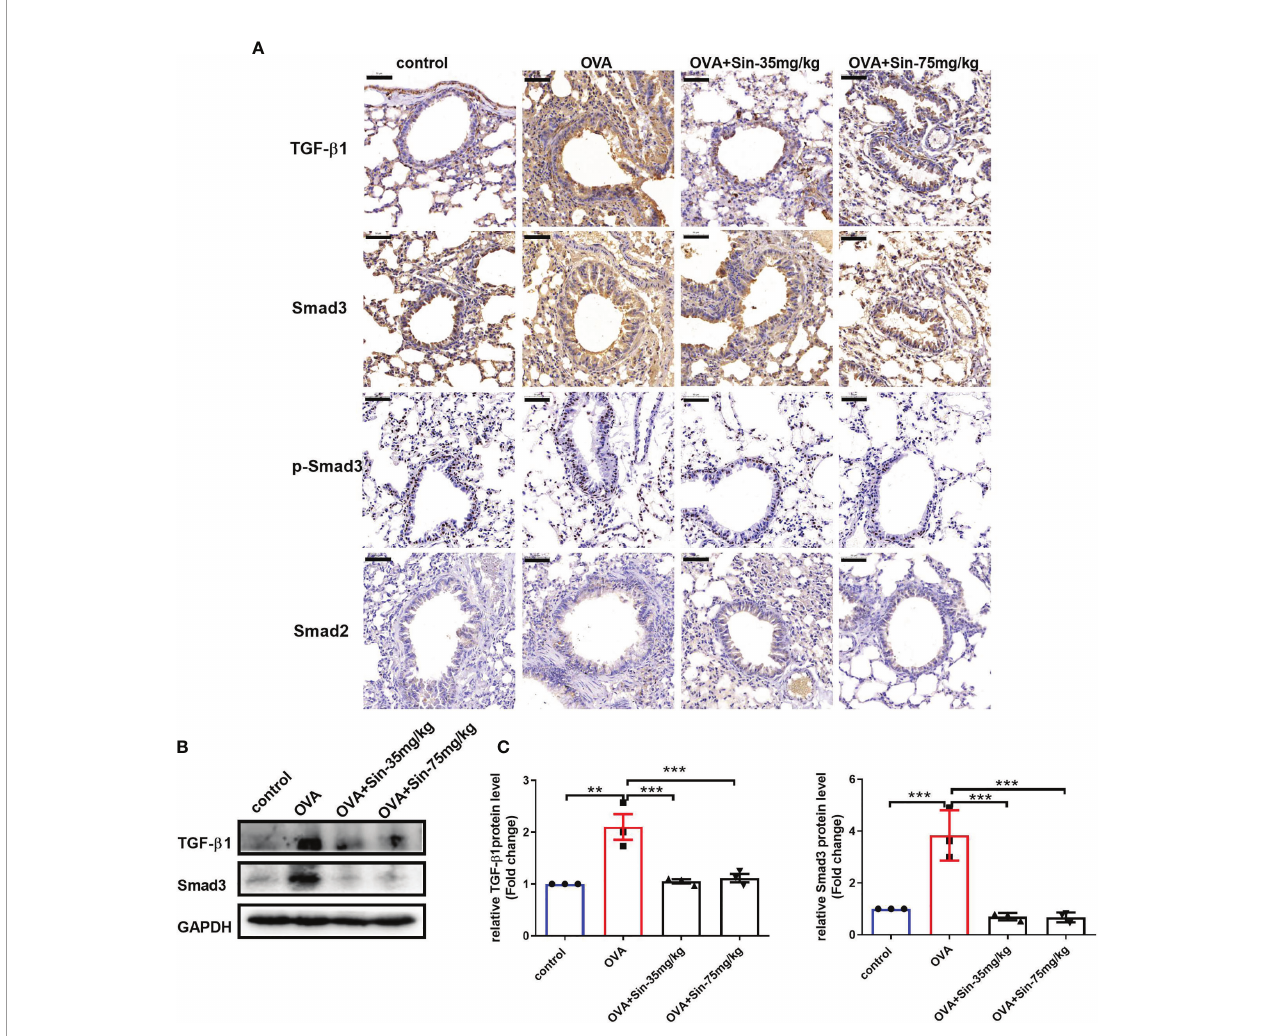
FIGURE 6 | Sin inhibited the TGF- b 1/Smad3 expression in the lungs of mice with OVA-induced mice asthma. (A) Protein levels of TGF- b 1, Smad3, p-Smad3 and Smad2 were detected using immunohistochemistry. Scale bar indicates 50 m m. (B) Protein levels of TGF- b 1 and Smad3 in the lung tissue were determined by Western blotting. (C) , Statistical data of the gray values of each protein normalized to GAPDH. The data are presented as mean ± SEM from three independent experiments. The one-way analysis of variance followed by Dunnett ’ s Multiple Comparison Test was used. **p < 0.01. ***p < 0.001. ns, no signi fi cant difference between the two